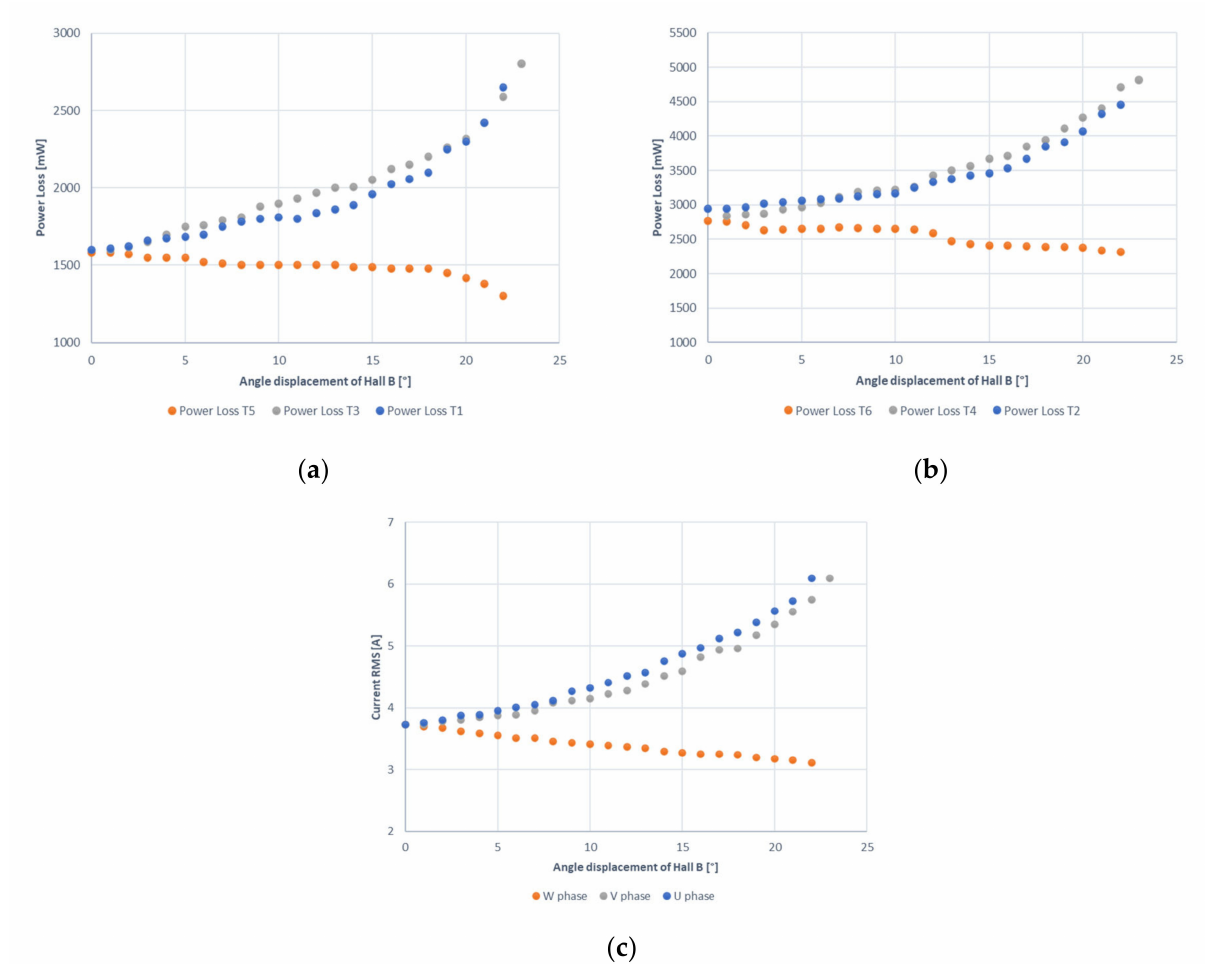
Figure 4. Experimental results as a function of angle displacement of Hall B sensor: ( a ) power loss in the high-side switch; ( b ) power loss in the low-side switch (include body diode loss); ( c ) RMS phase